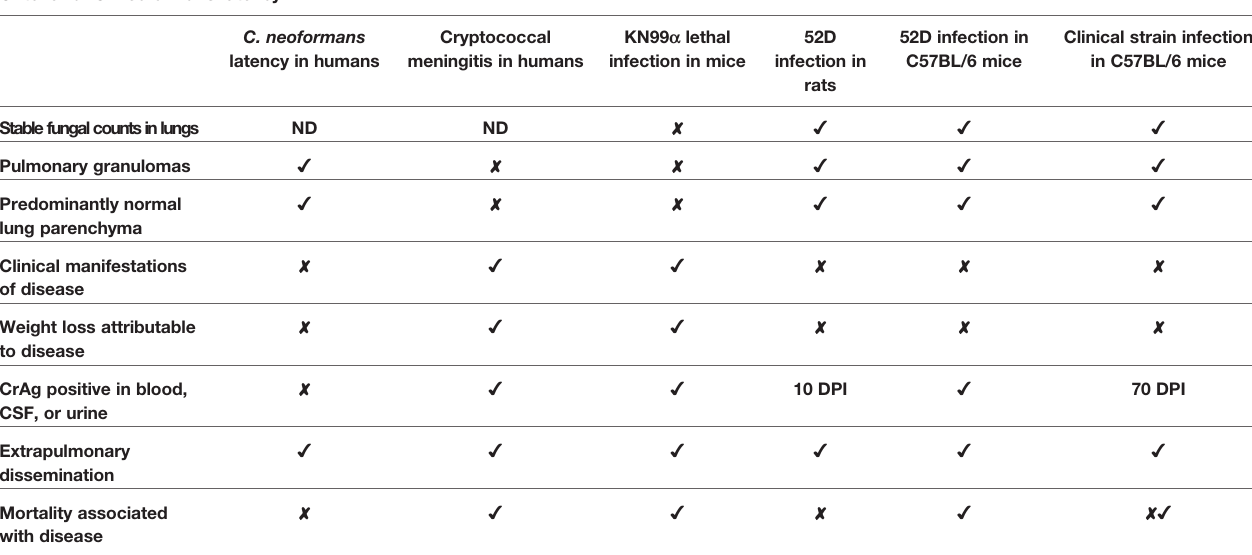
TABLE 1 | Criteria for latent C. neoformans infection models. Criteria for C. neoformans